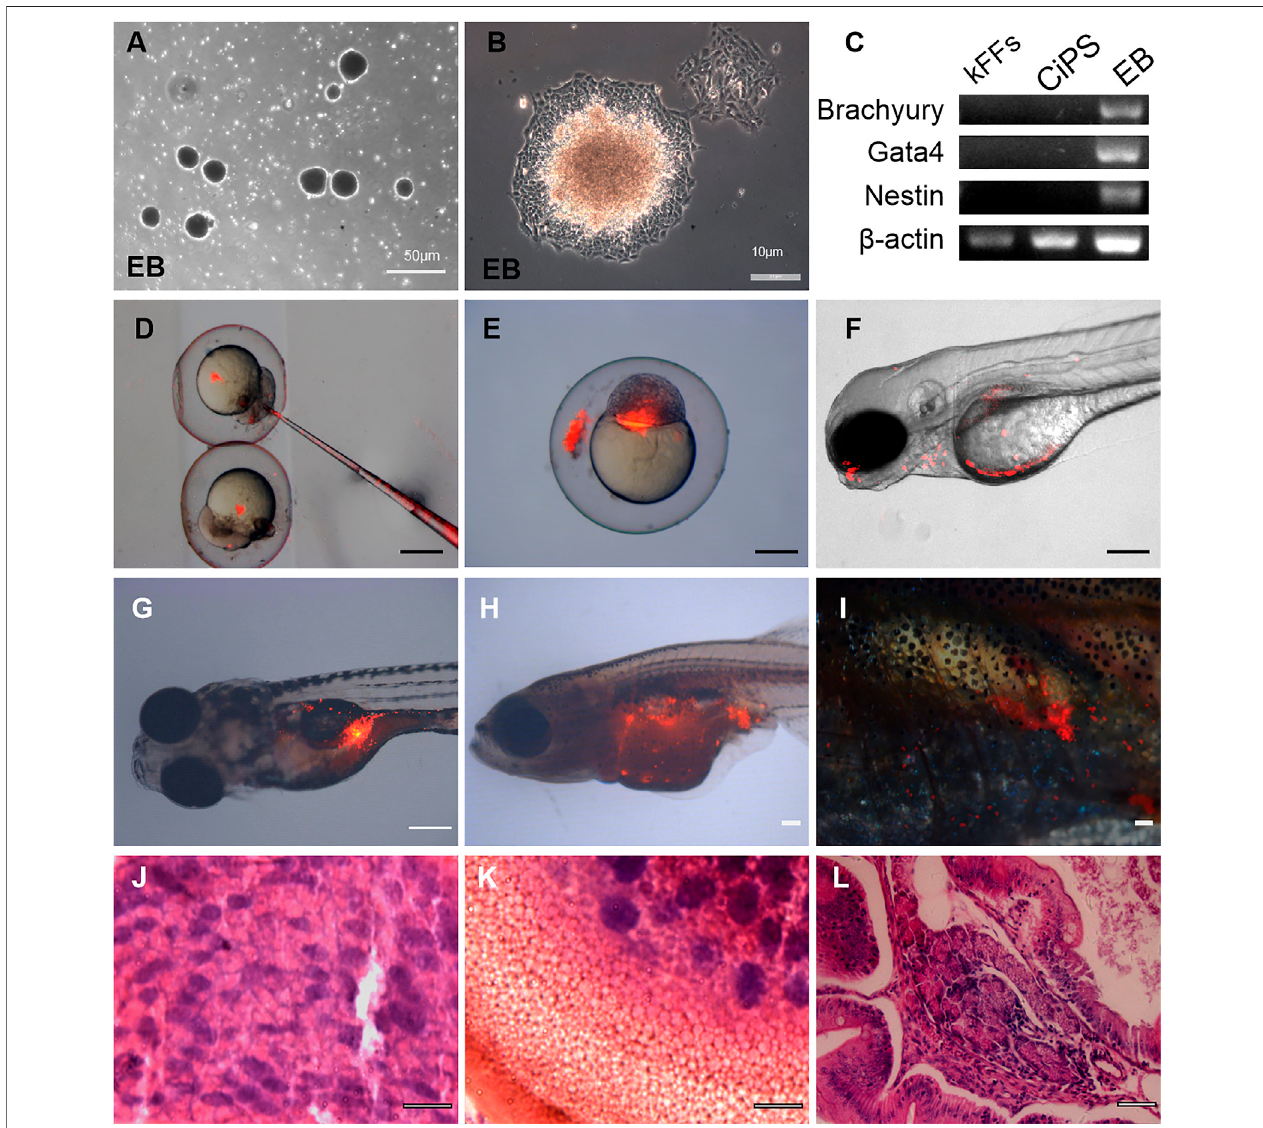
FIGURE 3 | Differentiation potential ofKio-CiPSLCs derived from kFFs. (A,B) The embryoid body (EB) formation (A) and differentiation (B) . (C) RT-PCR analysis of ectoderm marker gene ( Nestin ), mesoderm marker gene ( Brachyury ), and endoderm marker gene ( Gata4 ) in the three germ layers. (D – F) Different distributions of PKH26-labeled donor cells(Kio-CiPSLCs, passage 15,red) indifferent stages, inwhich thechimeras wereanalyzed bymicroscopy at 5 days post-fertilization (F) . Scale bars, 200 μ m. (G – I) PKH26-labeled Kio-CiPSLCs (passage 15, red) were transplanted with approximately 1,000 cells to host zebra fi sh, and the teratomas were analyzed after 8 weeks post-injection. Of the 30 injected fi sh, teratomas were observed in fi ve fi sh. Scale bars, 200 μ m. (J – L) Histology of various tissues present in teratomas derived from Kio-CiPSLCs. Neural epithelium (ectoderm) (J); Cartilage (mesoderm) (K) ; Gut-like epithelium (endoderm) (L) . Scale bars, 50 μ m.